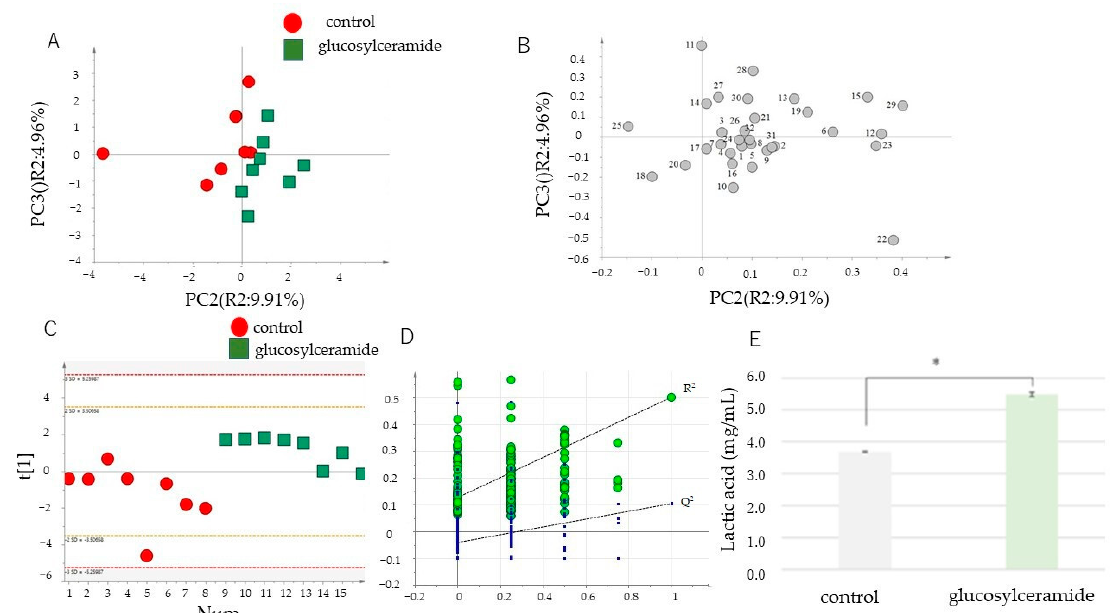
Figure 1. Metabolite analysis of the Blautia coccoides culture treated with glucosylceramide. ( A ) Score plot of principal component analysis (PCA) of metabolites of B. coccoides treated with or without 20 µ g/mL glucosylceramide. ( B ) Loading plot of metabolites of B. coccoides treated with or without 20 µ g/mL glucosylceramide. The substances corresponding to the numbers are listed in Table 1. ( C ) Partial least squares-discriminant analysis (PLS-DA) of metabolites of B. coccoides treated with or without 20 µ g/mL glucosylceramide. ( D ) The validated plot of PLS-DA of metabolites of B. coccoides treated with or without 20 µ g/mL glucosylceramide after a permutation test ( n = 200). ( E ) Lactic acid concentration (mg/mL) of B. coccoides cultures (24 h) treated with or without 20 µ g/mL glucosylce- ramide and 2 mM DCA from the start of the culture in YCFA medium. Statistical difference of the means was verified using one-sided unpaired Student’s t -test ( n = 3, * p <